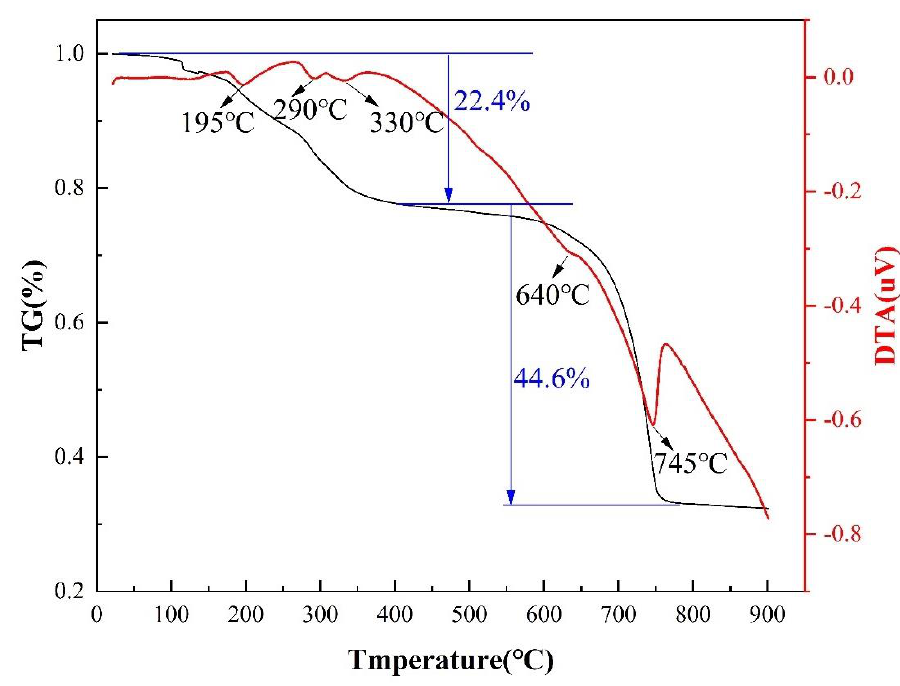
Figure 10. TG-DTA curves of the samples prepared in air from room temperature to 900 °C.